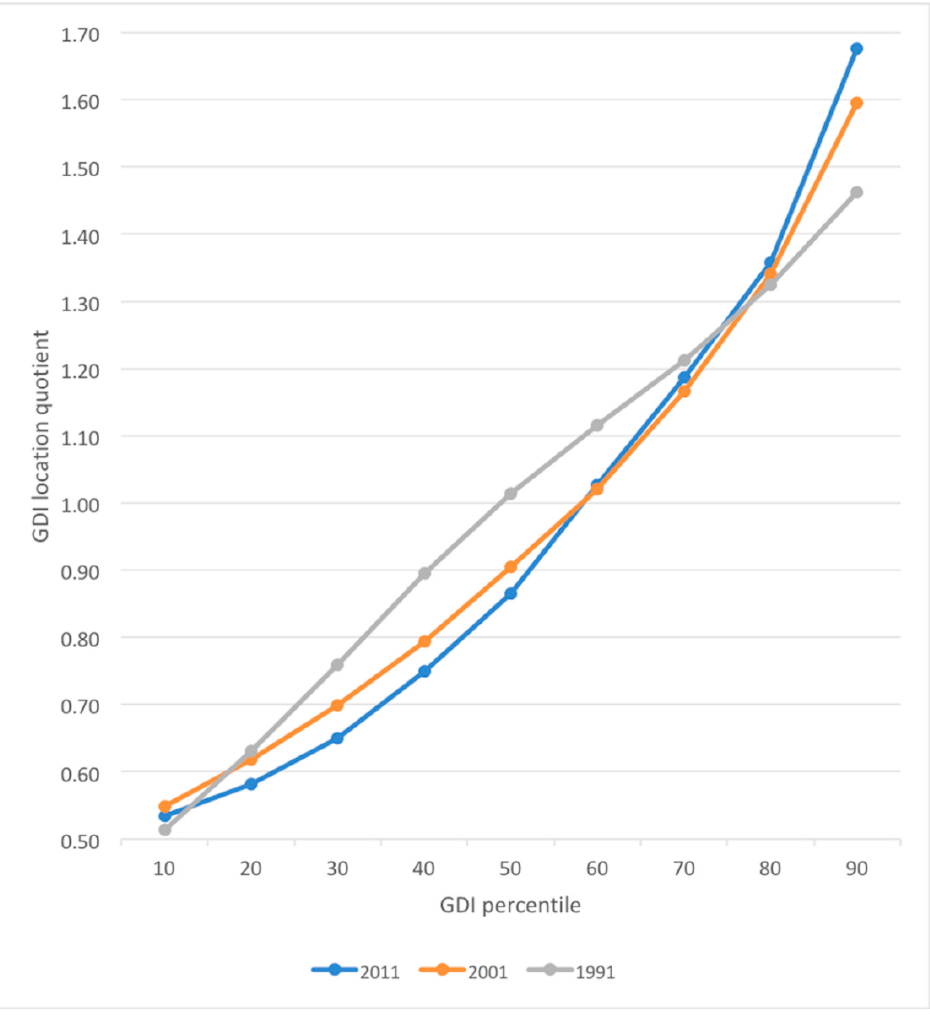
Figure 7. General Deprivation Index in Athens by decile (1991–2011).